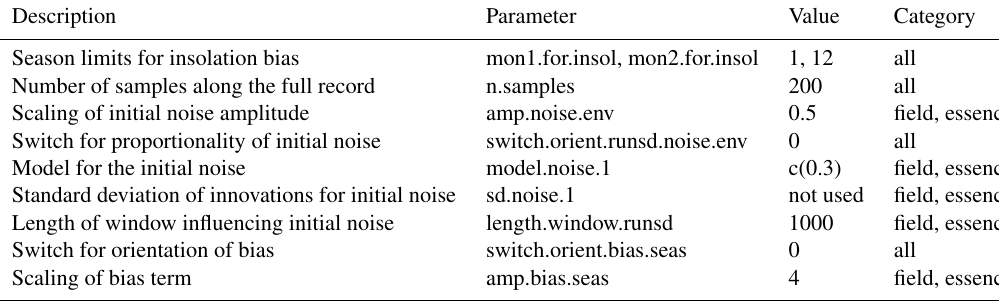
Table A1. List of parameters used.